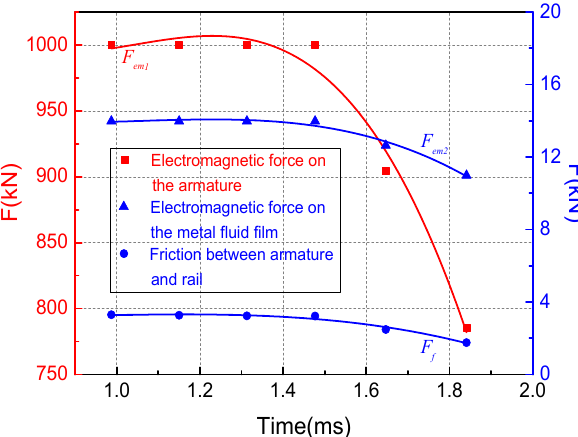
Figure 15. Electromagnetic force and frictional resistance during launch.